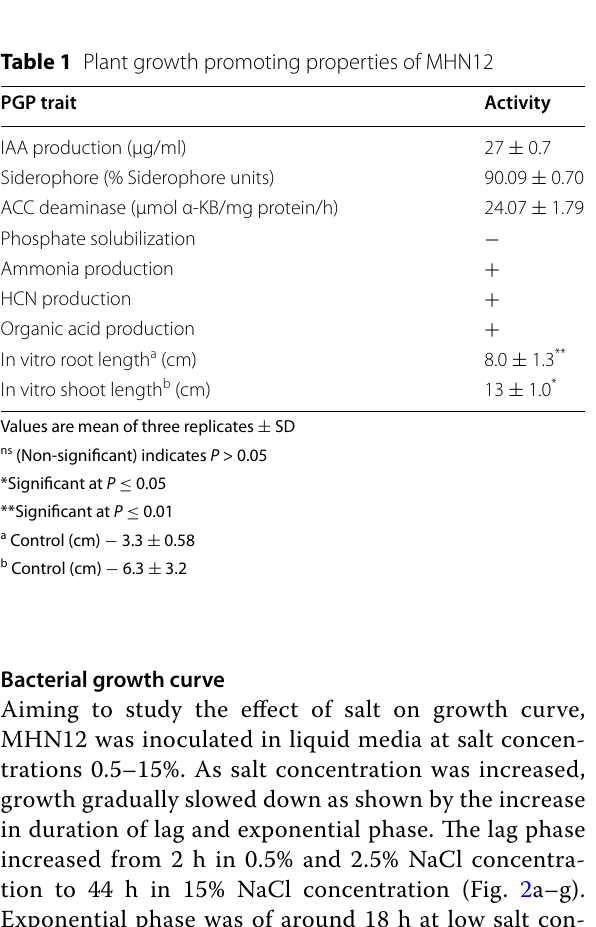
Table 1 Plant growth promoting properties of MHN12